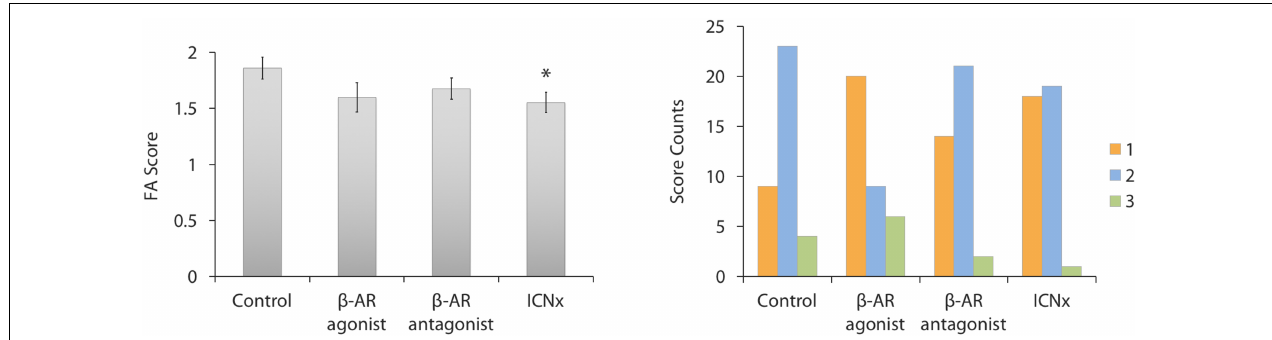
FIGURE 1 | FA scores 14 days after laser injury in each experimental group ( n ≥ 35 lesions per group from five animals per group). Four laser burns were made per eye. (Left) Average lesion score in each group. Scores in the ICN transection group were significantly lower than scores in the control group (* P < 0.05). Error bars indicate SEM. (Right) Histogram showing the distribution of FA scores in each